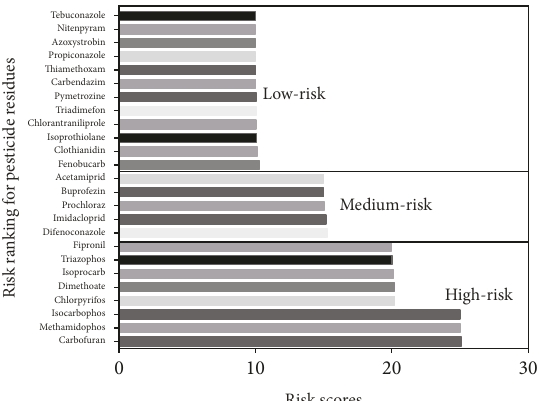
Figure 4: Risk ranking for pesticide residues in brown rice sample. High risk with a score > 20, medium risk with a score of 15–20, and low risk with a score < 15.